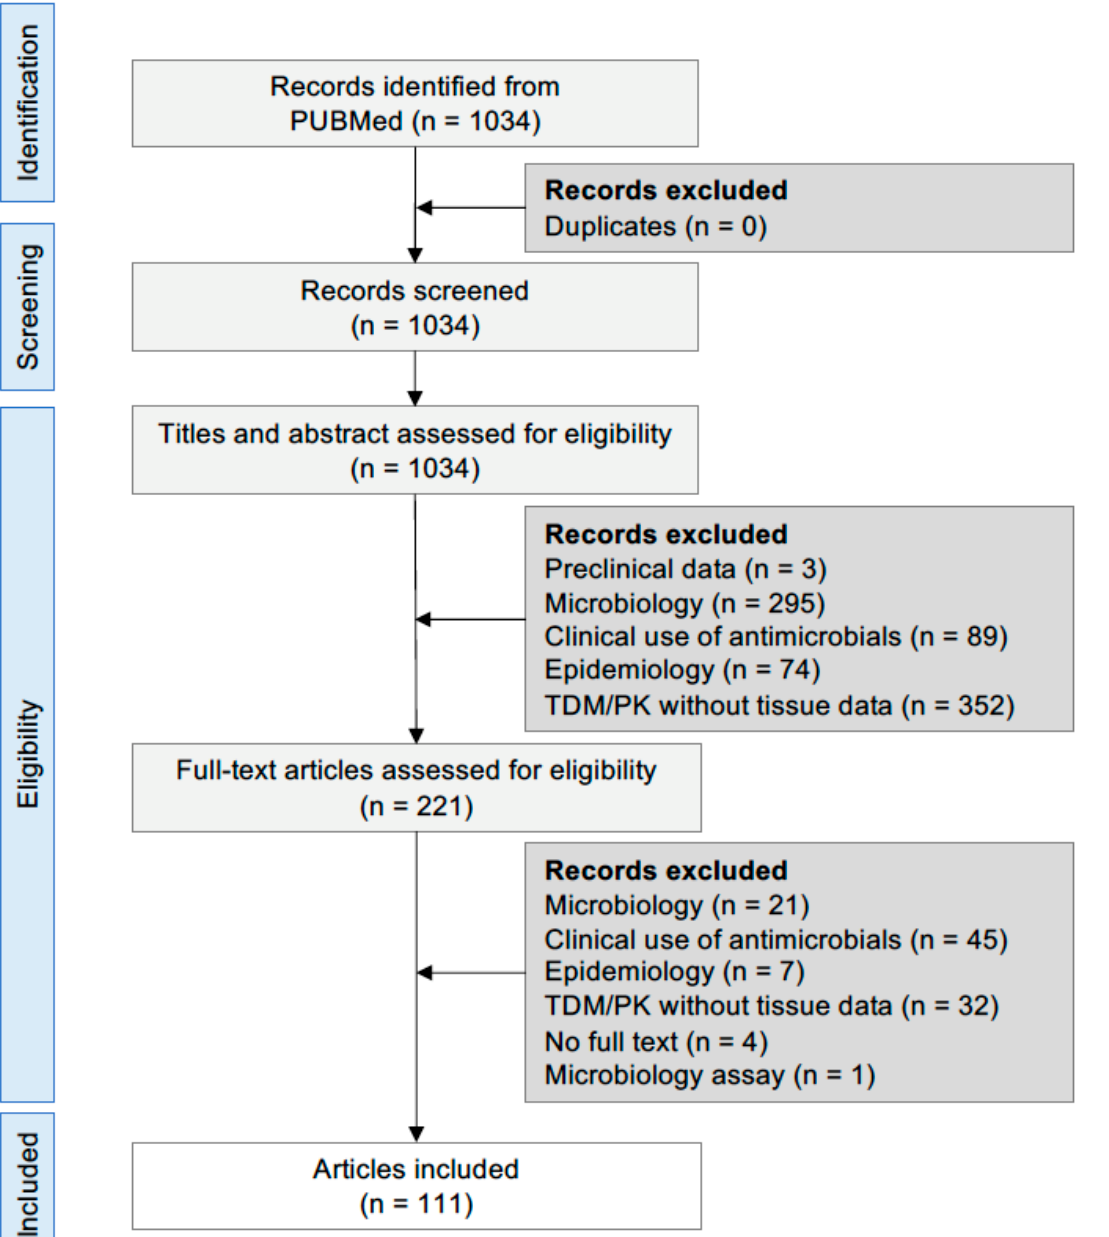
Figure 1. PRISMA flow diagram. Abbreviations: TDM, therapeutic drug monitoring; PK, pharmacokinetics.